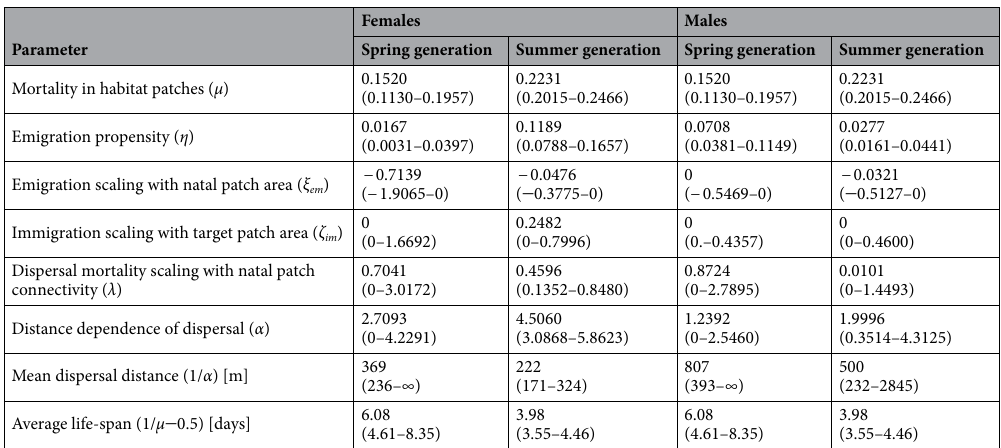
Table 2. Dispersal parameter estimates (with their 95% confidence intervals in parentheses) obtained for L. helle butterflies with the Virtual Migration model in 2018. Following the outcome of the Cormack-Jolly-Seber models, no inter-sexual difference in mortality in habitat patches, and consequently also in average adult life- span, was assumed (see the Methods section for details).